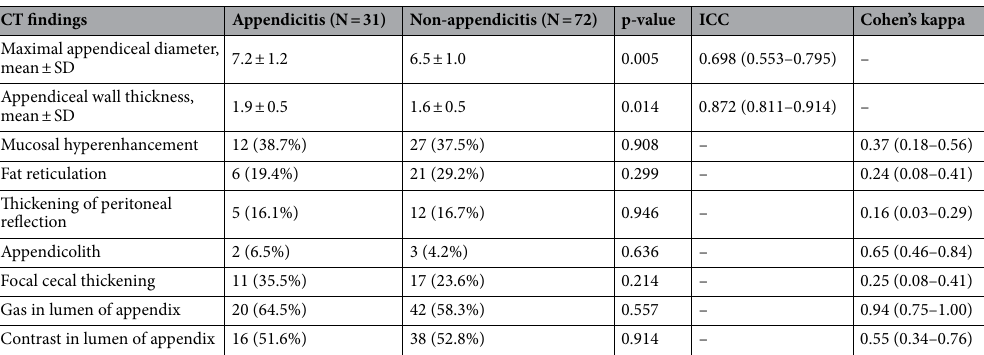
Table 2. Comparison of CT findings between appendicitis and non-appendicitis groups. ICC: intraclass correlation coefficient.